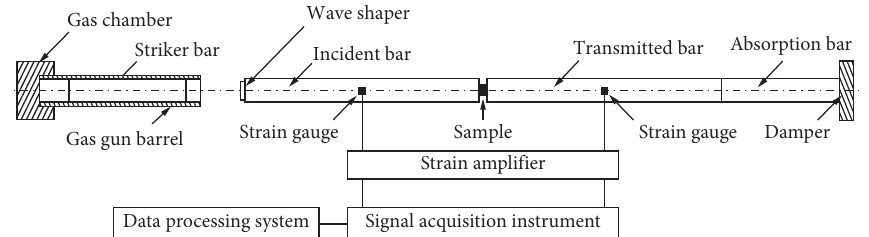
Figure 5: Schematic diagram of the SHPB test system.